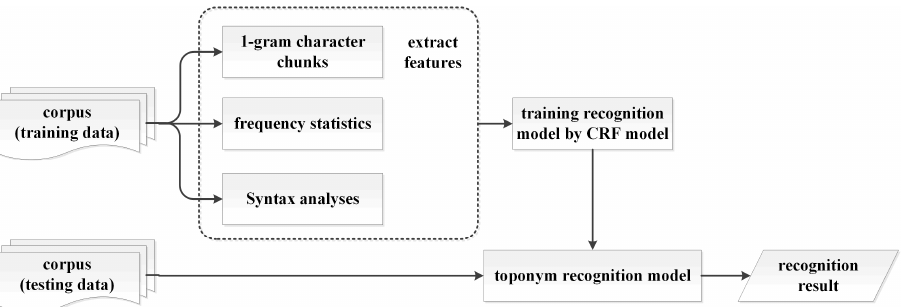
Figure 11. The main processes of a CRF-based approach. Table 5. Main features of the CRF model.